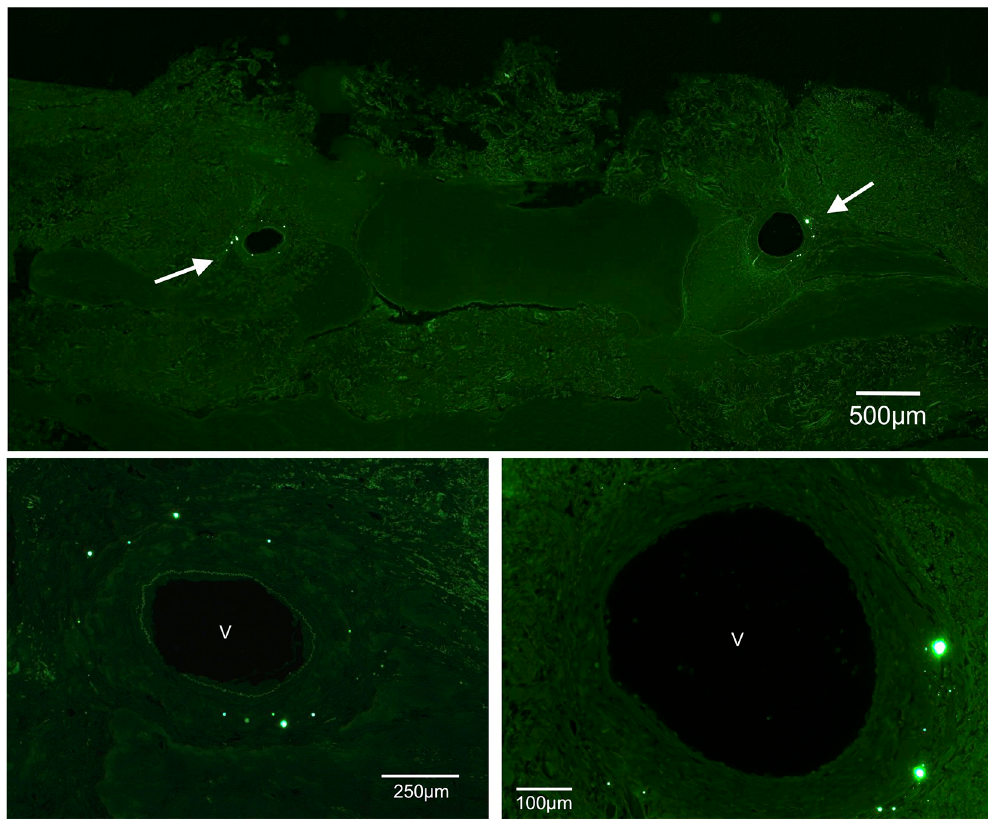
Fig 3. Fluorescence microscopy; above: overview of a cut section through an AVL-construct showing QDots around the vessels (arrows). Below: higher magnification showing the labelled cells in clusters leading to an intensive signaling, v: cross section of the vessel, green filter, peak emission at 565